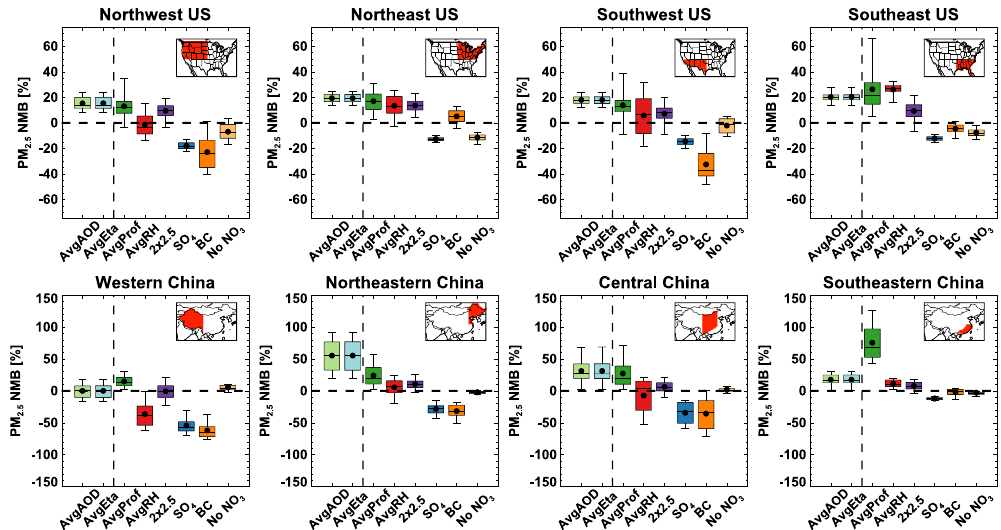
Figure 8. Distribution of normalized mean biases in annual average PM 2 . 5 for grid boxes in different regions of the US (top row) and China (bottom row) determined from sensitivity tests to investigate the uncertainty in η . Sensitivity tests are described (and abbreviations defined) in Table